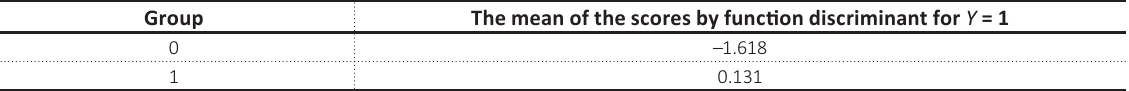
Table B9. The mean of scores per